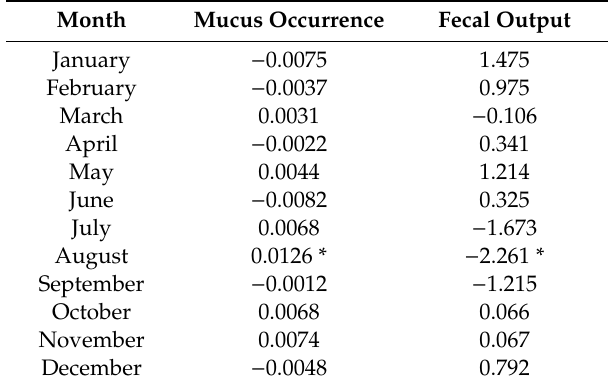
Table 3. Results of monthly changes of seasonal factors for mucus occurrences and fecal output in time series